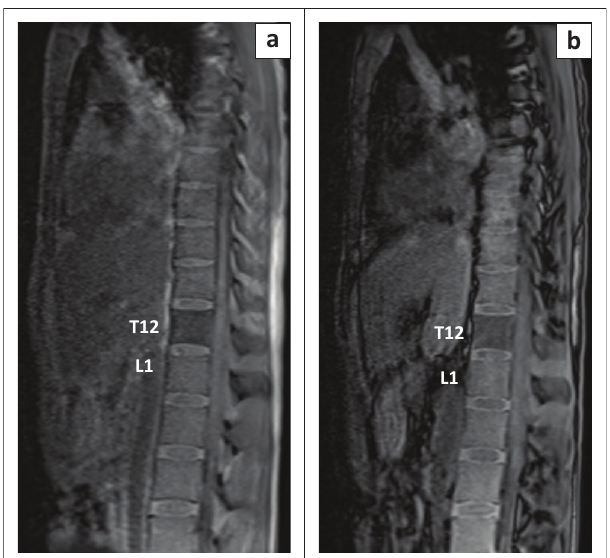
FIGURE 3: Sagittal T1W sequences acquired in phase (a) and opposed phase (b) show that the involved T12 vertebral body does not show reduction in signal on opposed phase images. This finding suggests a bone marrow infiltrating disorder as opposed to red marrow conversion, where signal reduction is expected due to presence of microscopic fat in red marrow.